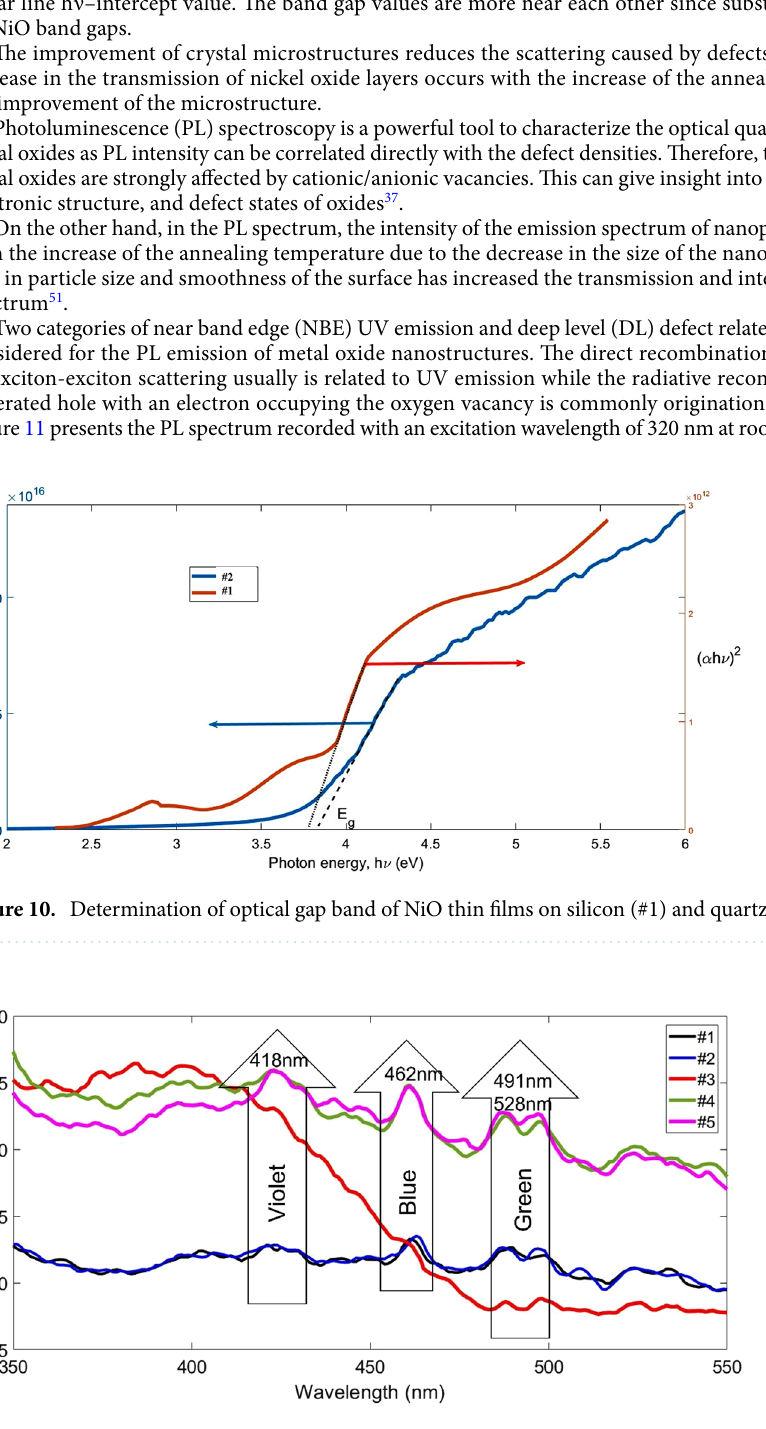
Figure 11. The PL spectra of as deposited and annealed NiO thin